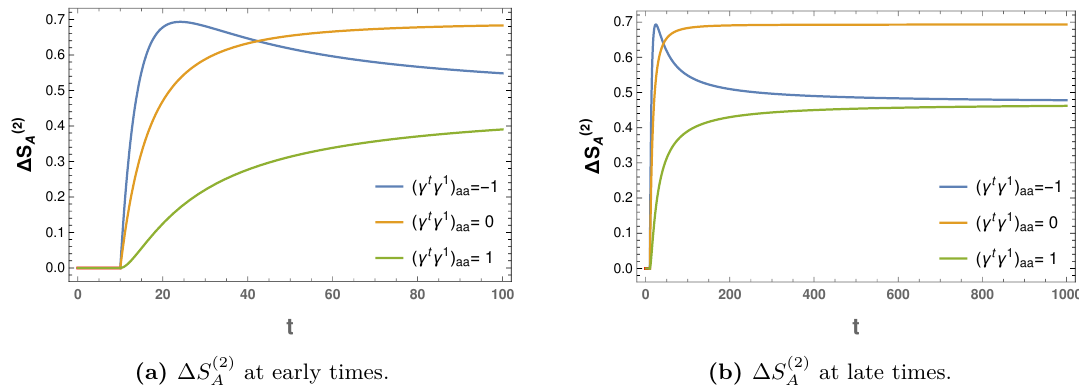
Figure 3. Time evolution of Rényi entropy ∆ S (2) with various choices of ( γ t γ 1 ) aa = 0 , ± 1 . Note A that for ( γ t γ 1 ) aa = 0 , the Rényi entropy approaches to log 2 as time evolves. This is due to the generation of EPR pairs. For ( γ t γ 1 ) aa = ± 1 it approaches a constant value ( ≈ 0 . 47 ) at late times. Here we choose L = 10